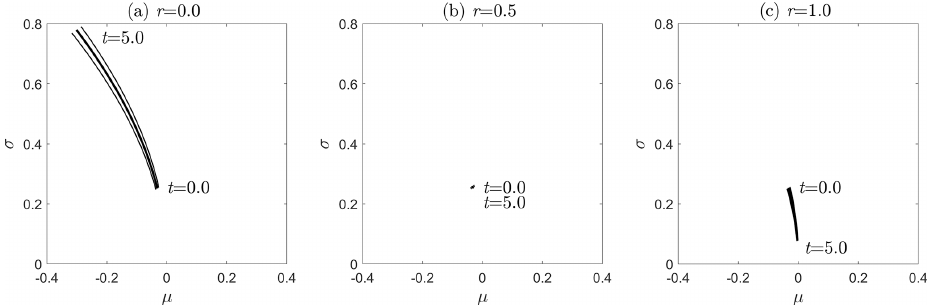
Figure 5. Parameters µ and σ of a lognormal distributions fitted to the computed mass distribution in the compound model at the parameter values r = 0 . 0 (a) , r = 0 . 5 (b) , and r = 1 . 0 (c) from t = 0 until t = 5 . 0. Thick solid lines correspond to the best fit; thin lines indicate the 95% confidence level of the fit. Observe the narrow zone spanned by the confidence